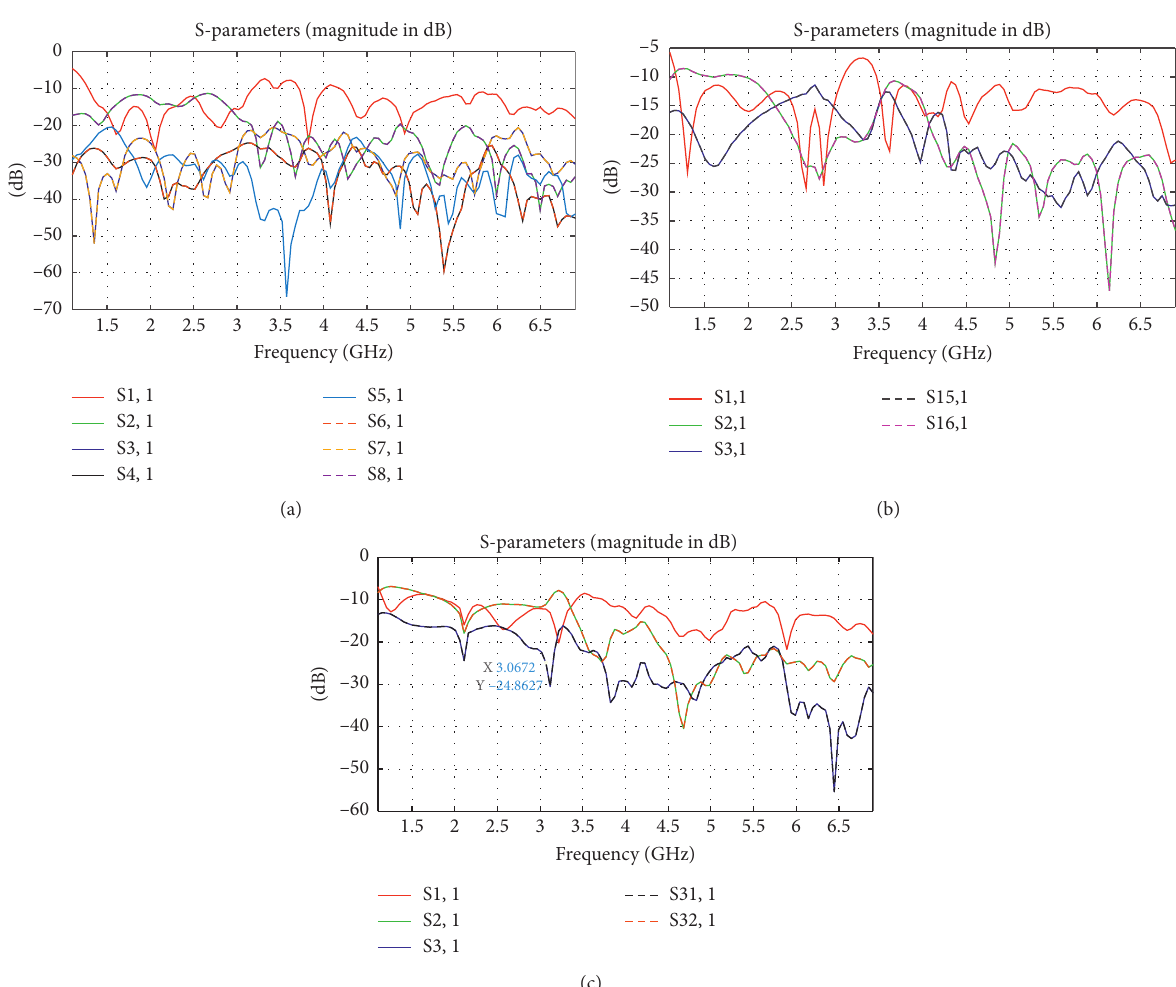
Figure 6: The vertical scattering matrix of (a) 8 elements, (b) 16 elements: S1, 1-S2, 1-S3, 1-S15, 1-S16, 1, and (c) 32 elements: S1, 1-S2, 1-S3, 1-S31, 1-S32,